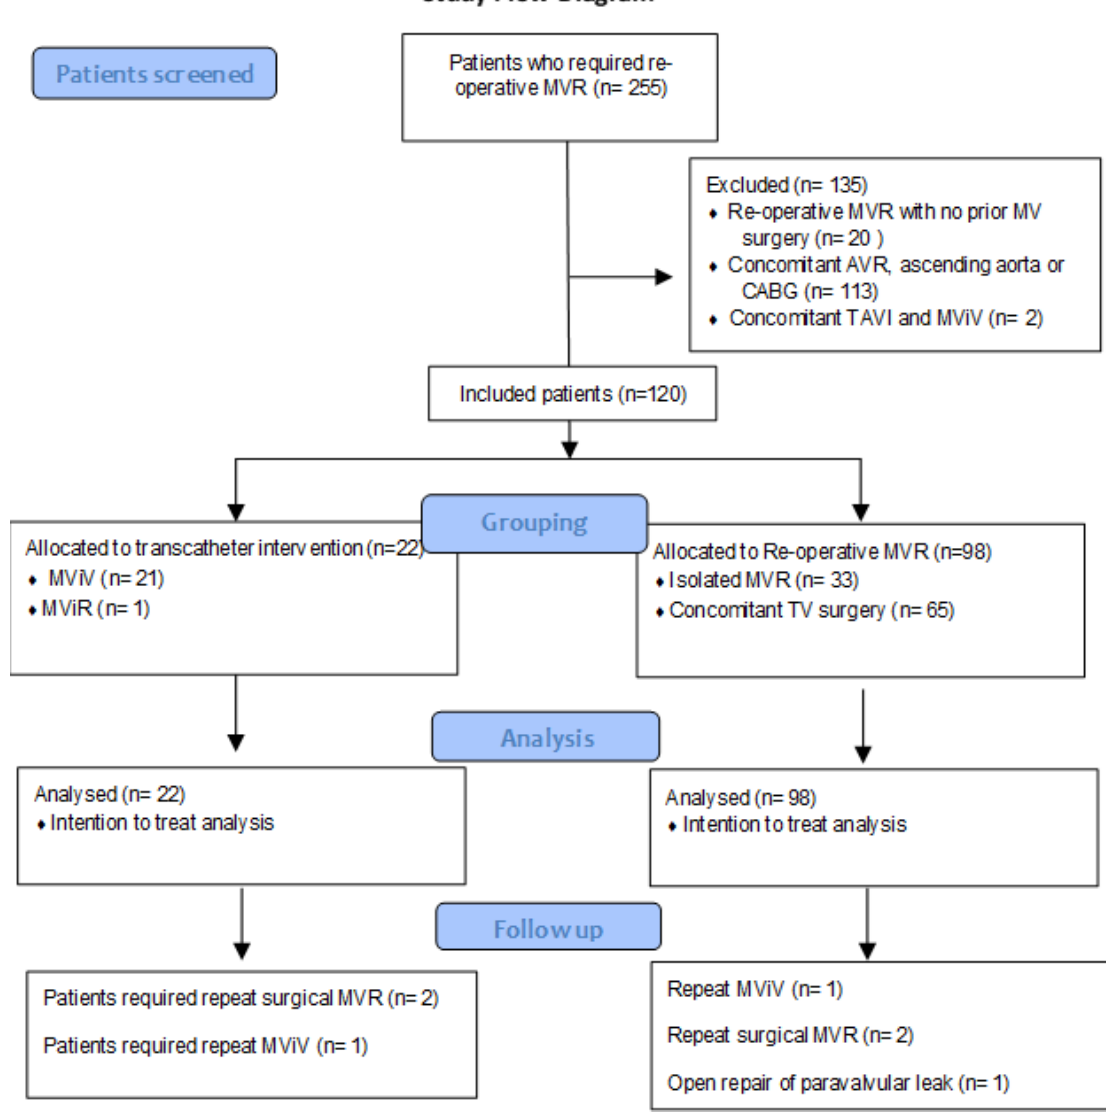
Fig. 1 - Study flowchart. AVR=aortic valve replacement; CABG=coronary artery bypass grafting; MVR=mitral valve replacement; MViR=mitral valve-in-ring; MViV=mitral valve-in-valve; TAVI=transcatheter aortic valve implantation; TV=tricuspid